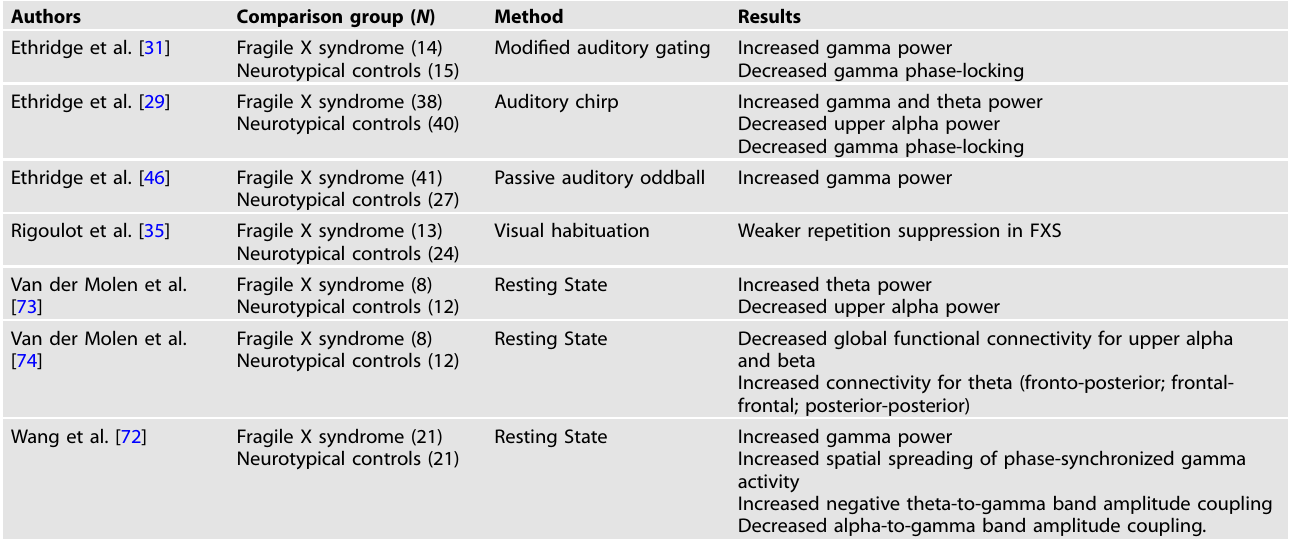
Table 2. EEG spectral power fi ndings in